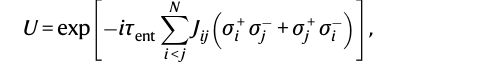
here is the same one used in refs.63, 69. b The pulse sequences of a pseudo- randomcircuitanditsequivalentgatemodel. U isaglobalentanglinggateandeach cubic box is a random single-qubit gate. c The schematic representation of the effective coupling graph of 15 qubits with an equal detuning Δ = 2 π ≈ (cid:2) 360 MHz from the central